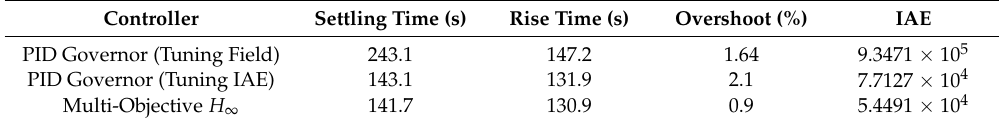
Table 5. Comparison between the set-point performance indexes of the different